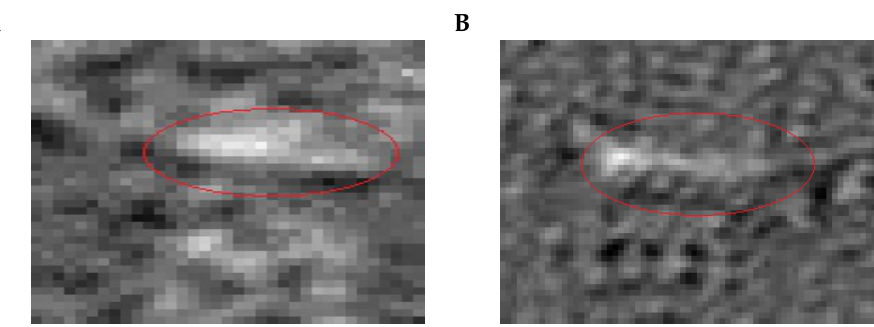
Figure 12. ( A ) for this sample, the isolation of EVs from HT29 cells employing affinity spin columns was performed; before EVs isolation, cell culture supernatants were filtrated via 0.45µm filter (see Methods for the details); ( B ) for this sample, the EVs were prepared by adding to the collected cell culture supernatants a special buffer, which helped to tie up and to force the EVs out of the solution (details provided in Methods). The thin-line red ellipses mark vesicle binding signals. The long axis of the red ellipse on panel A has a size of approx. 8.36µm. The long axis of the red ellipse on panel B has a size of approx. 15.96µm.